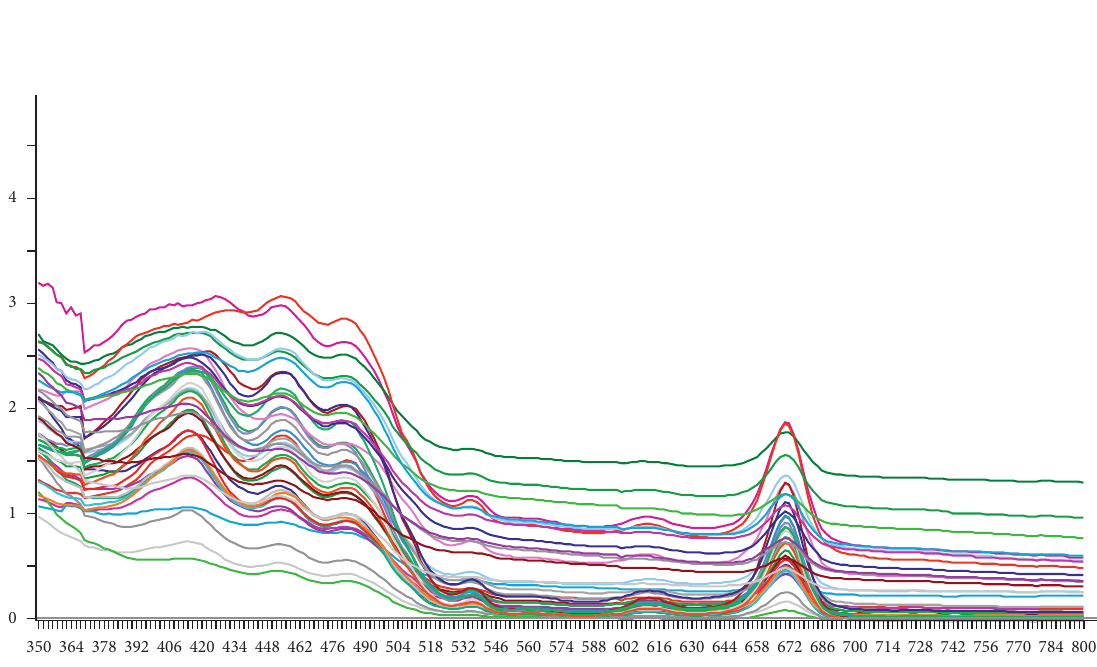
Figure 1: ATR-FTMIR spectra of the collected olive oil